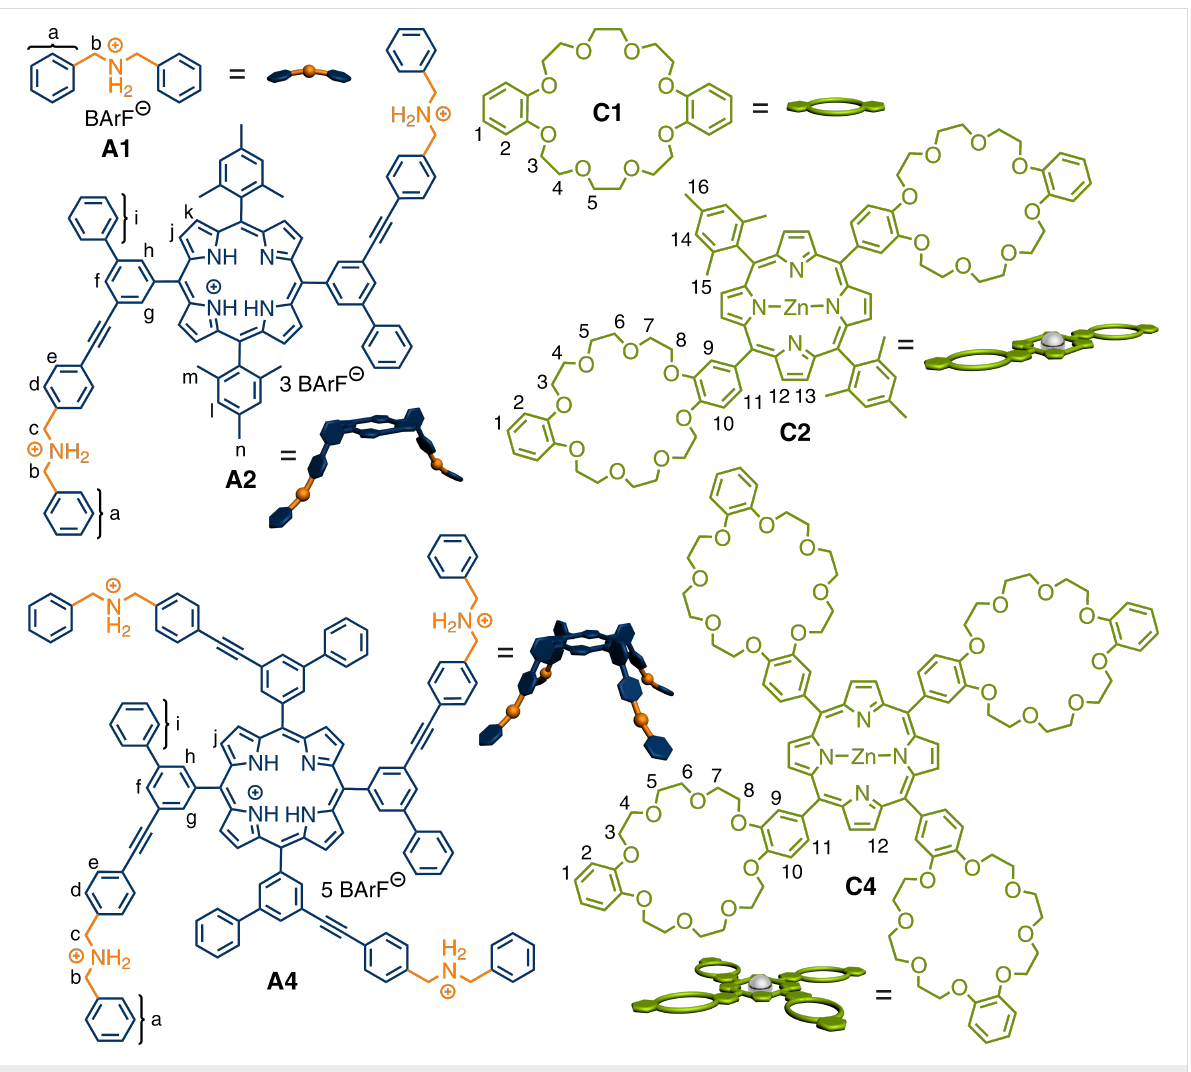
Figure 1: Mono-, di-, and tetravalent axles A1 , A2 and A4 and mono-, di-, and tetravalent hosts C1 , C2 and C4 . Numbers and letters are assigned to specific H atoms as discussed later in the main